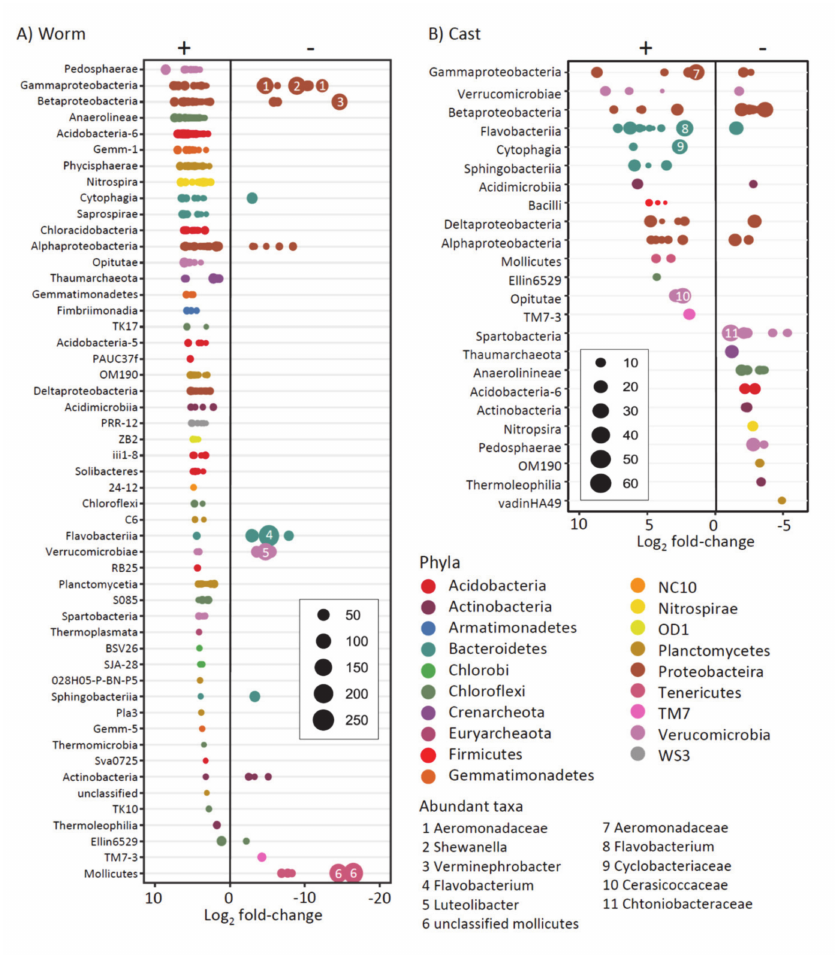
Figure 5. Bacterial OTUs that were significantly increased or depleted in the Hg-contaminated treatment in comparison to the uncontaminated control in earthworm ( A ) and cast ( B ) samples from experiment 1. The size of the points represents the square root of the read abundance of the OTUs. The OTUs are listed by taxonomic class, and points are color coded according to taxonomic